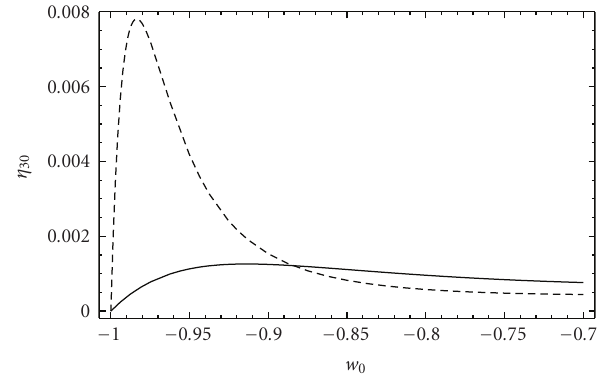
Figure 2: The dimensionless ratio between the present day values of f (cid:7)(cid:7)(cid:7) ( R ) and f ( R ) as function of the constant EoS w 0 of the corresponding quiessence model. Short dashed and solid lines refer to models with Ω M = 0 . 041 and 0 . 250, respectively.